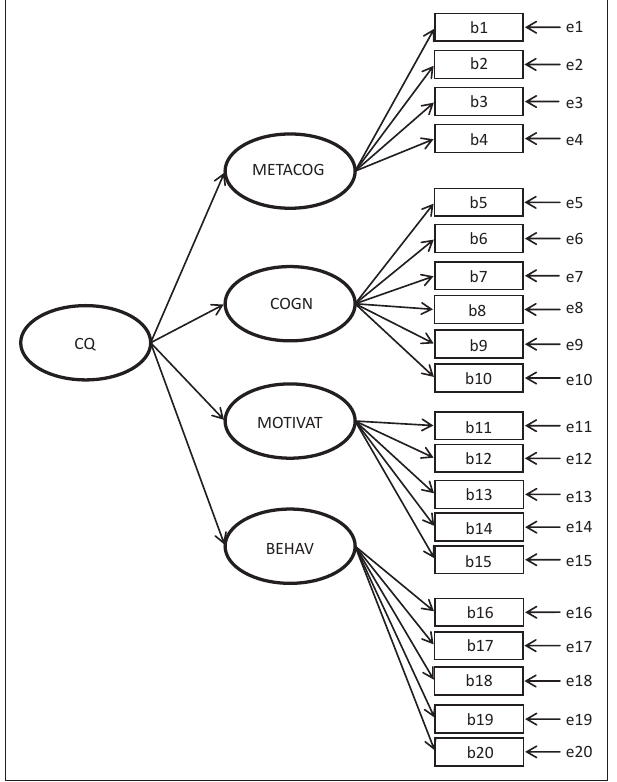
FIGURE 1: The cultural intelligence scale second-order confirmatory factor analysis path diagram indicating four first-order factors loading onto a single second-order cultural intelligence